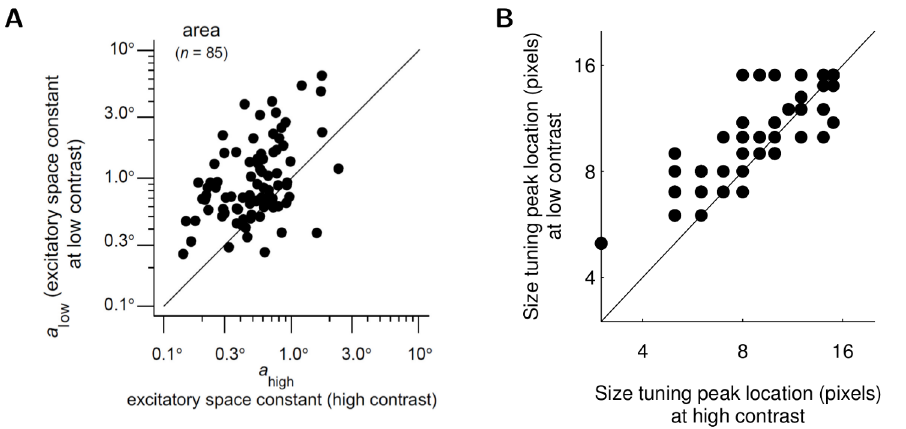
Figure 4. Size tuning peak at high vs. low contrast. (A) RF expansion of macaque V1 cells (reprinted by permission from Macmillan Publishers Ltd: Nature Neuroscience, Figure 3a from [37]). (B) RF expansion of sparse coding model cells. Most points lie above the diagonal, indicating that (on average) the optimal stimulus size is larger at lower contrasts and the cell demonstrates RF expansion.